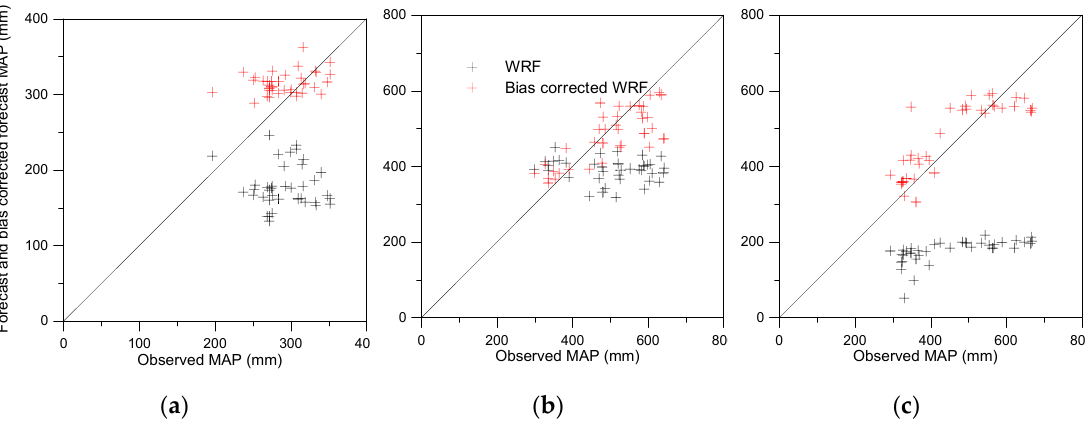
Figure 6. The scatterplot of the accumulated observed MAP and mean ensemble of real-time WRF data before and after bias correction for the events in ( a ) 2002, ( b ) 2007 and ( c ) 2011.